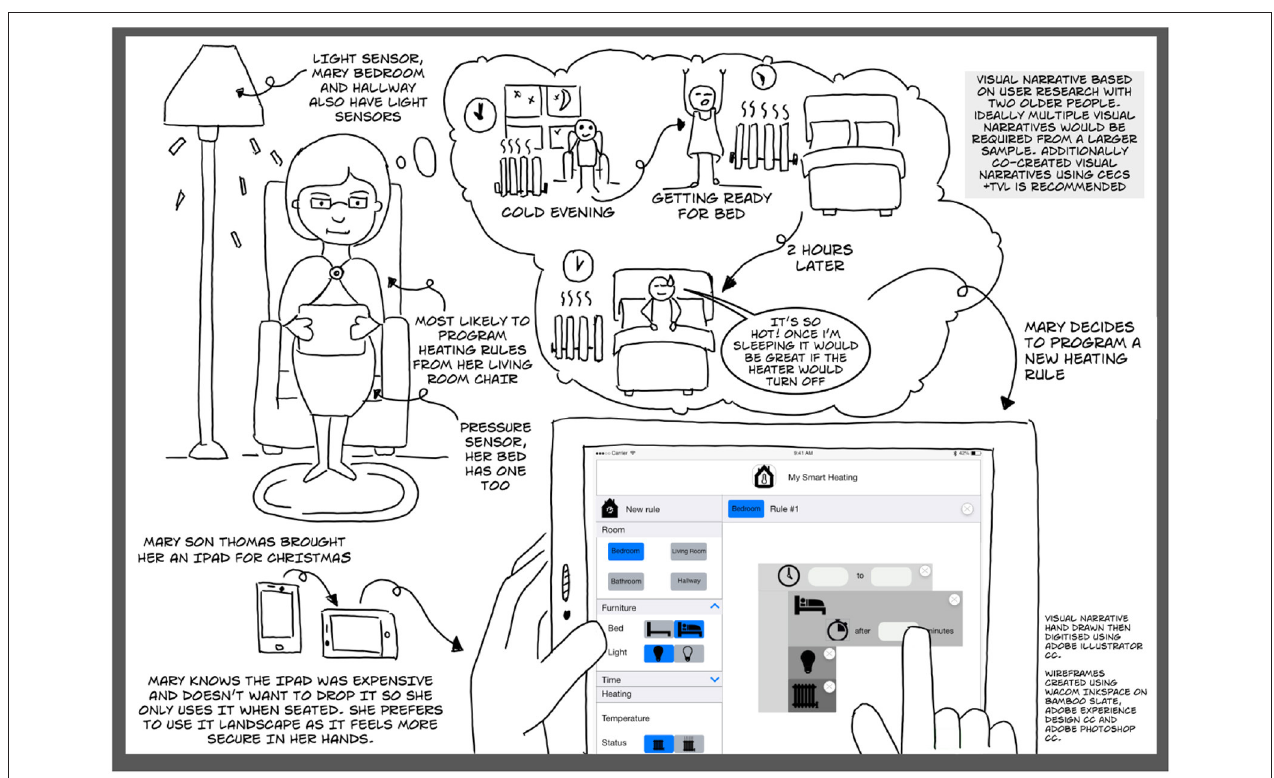
FIGURE 4 | Pre-COVID-19 exemplar of sketching in UX design: demonstrating contextual prototype vignette. Makayla Lewis, 2018.